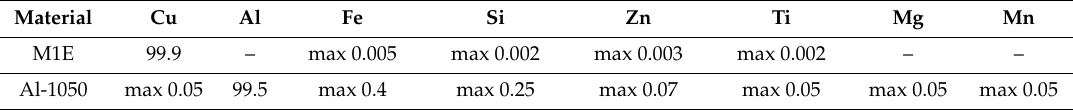
Table 1. Chemical composition of tested materials (mass percent) .